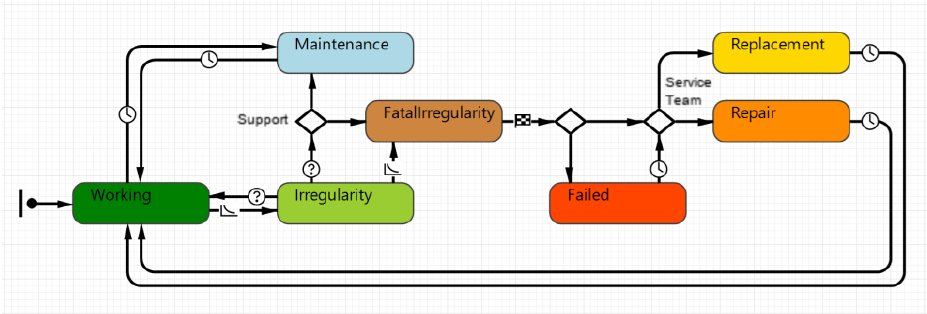
Fig 4. Downscaled example of a state chart of the machine